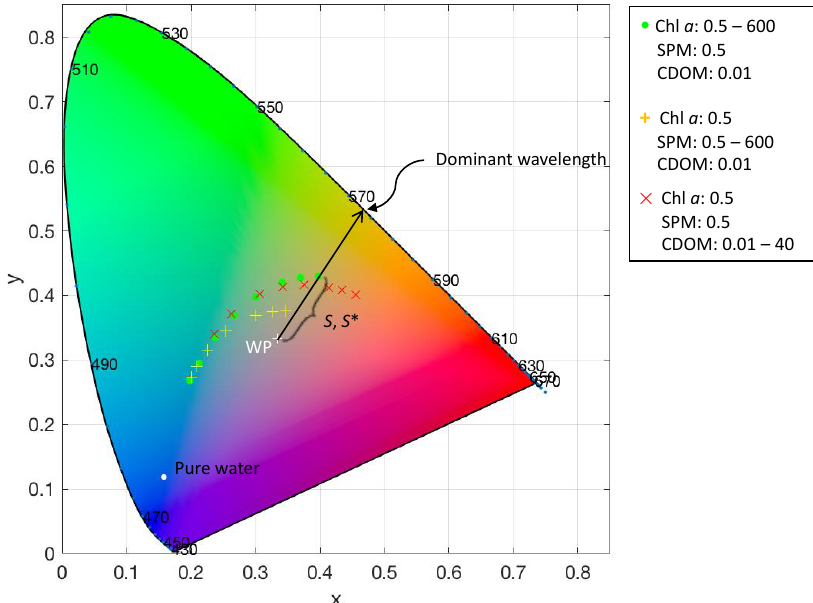
Figure 1. Chromaticity diagram showing the location of the white point (WP) and the x , chromaticity coordinates of a range of water types modelled by adding optically active substances to pure water according to a bio-optical model [13]. Dominant wavelength and distance to the white point ( S ) are illustrated using the rightmost round data point. Purity ( S *) is the distance S relative to the distance of the white point to the horseshoe-shaped envelope. The units for the optically active substances are: chl a (mg m −3 ), suspended particulate matter (SPM) (mg L −1 ), and coloured dissolved organic matter (CDOM) (absorption at 440 nm m −1 ).